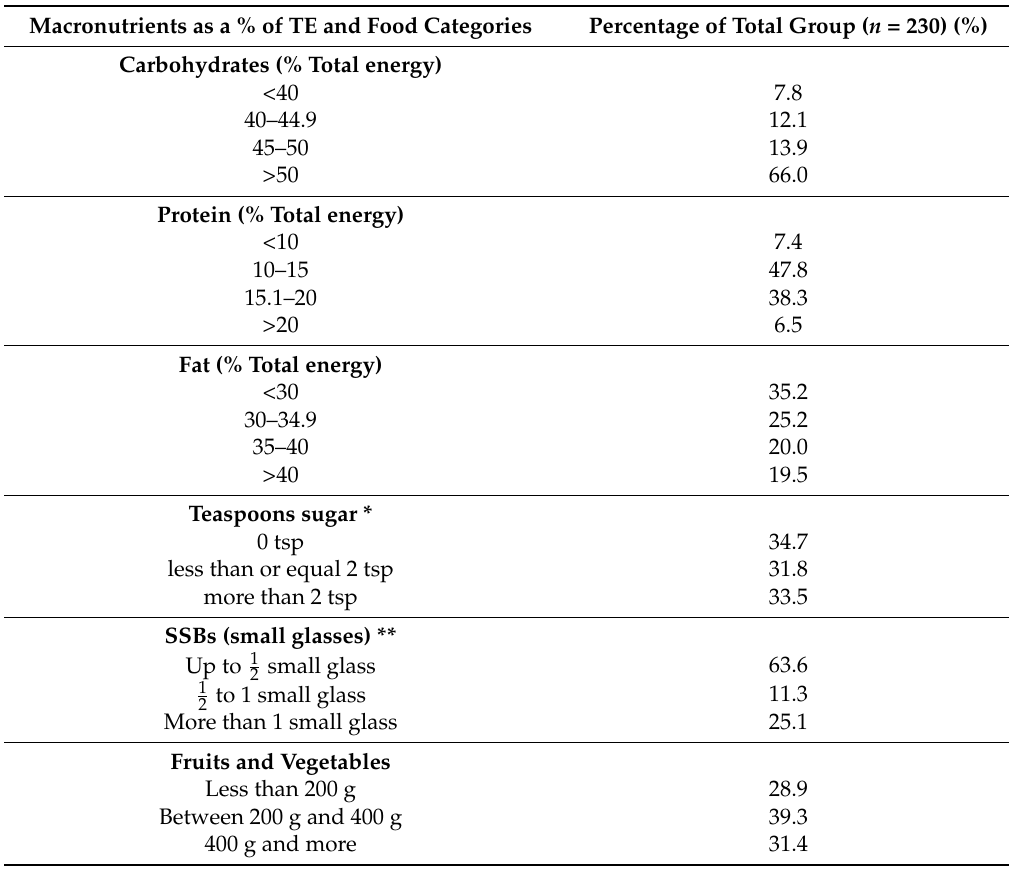
Table 4. Breakdown of the macronutrient distribution of the sample and the percentage of participants’ macronutrients intake as percent of total energy and intake of table sugar, sugar sweetened beverages (SSBs) and fruits and vegetables